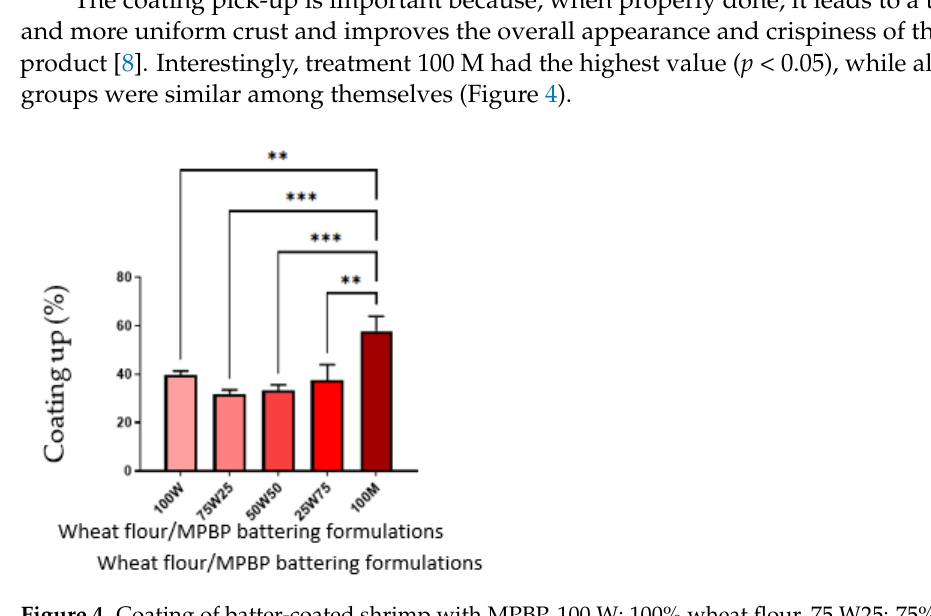
Figure 3. Oil absorption of batter-coated shrimp with MPBP. 100W: 100% wheat flour, 75W25: 75% wheat flour and 25% MPBP, 50W50: 50% wheat flour and 50% MPBP, 25W75: 25% wheat flour and 75% MPBP, 100M: 100. The error bars indicate standard division. * p < 0.05, ** p < 0.005, *** p < 0.0005, **** p < 0.00005.